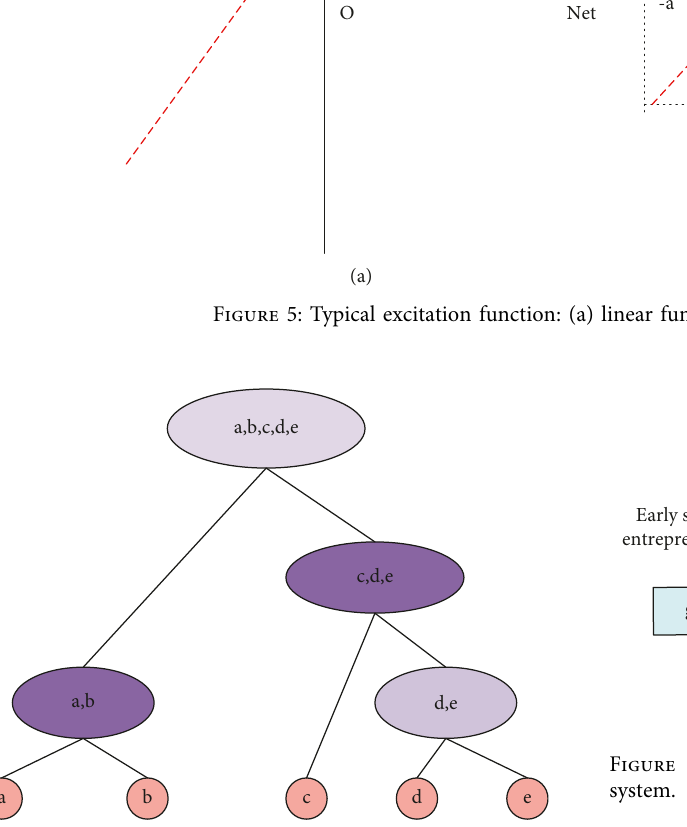
Figure 6: Example of a hierarchical clustering diagram.